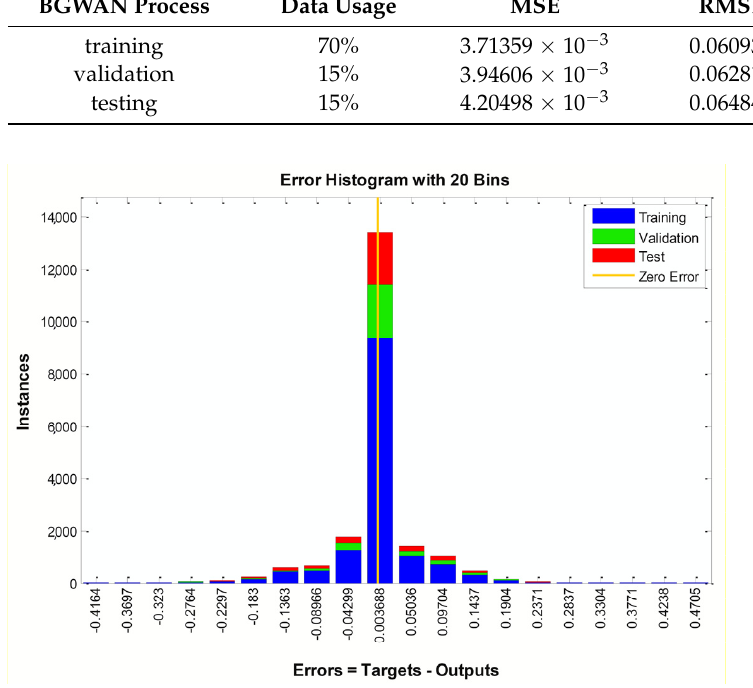
Figure 5. Error Histogram for ANN outputs.